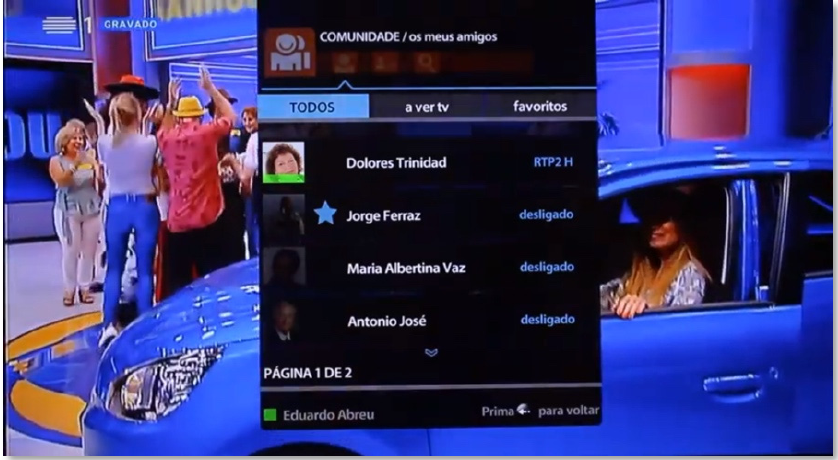
Figure 8. Community area of the SecurHome TV application.